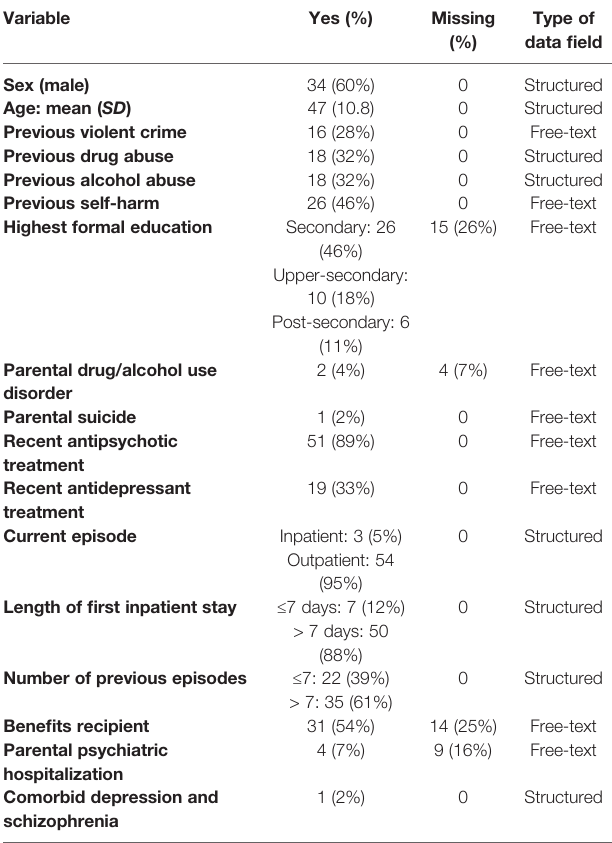
TABLE 1 | Study 1 sample characteristics for patients with severe mental illness